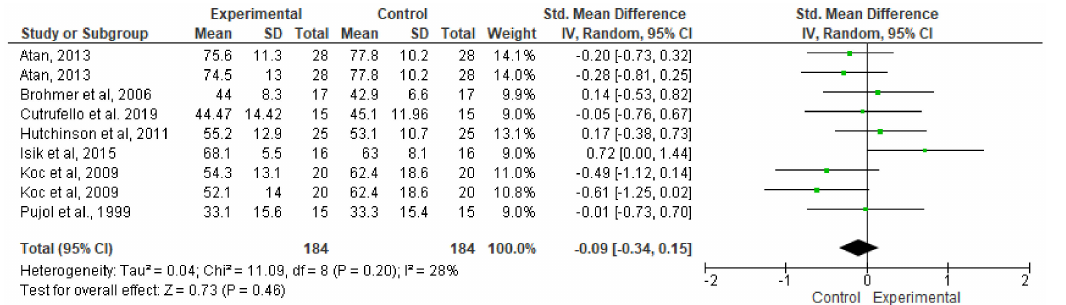
Figure 7. E ff ects of music on FI performance contrasted using forest